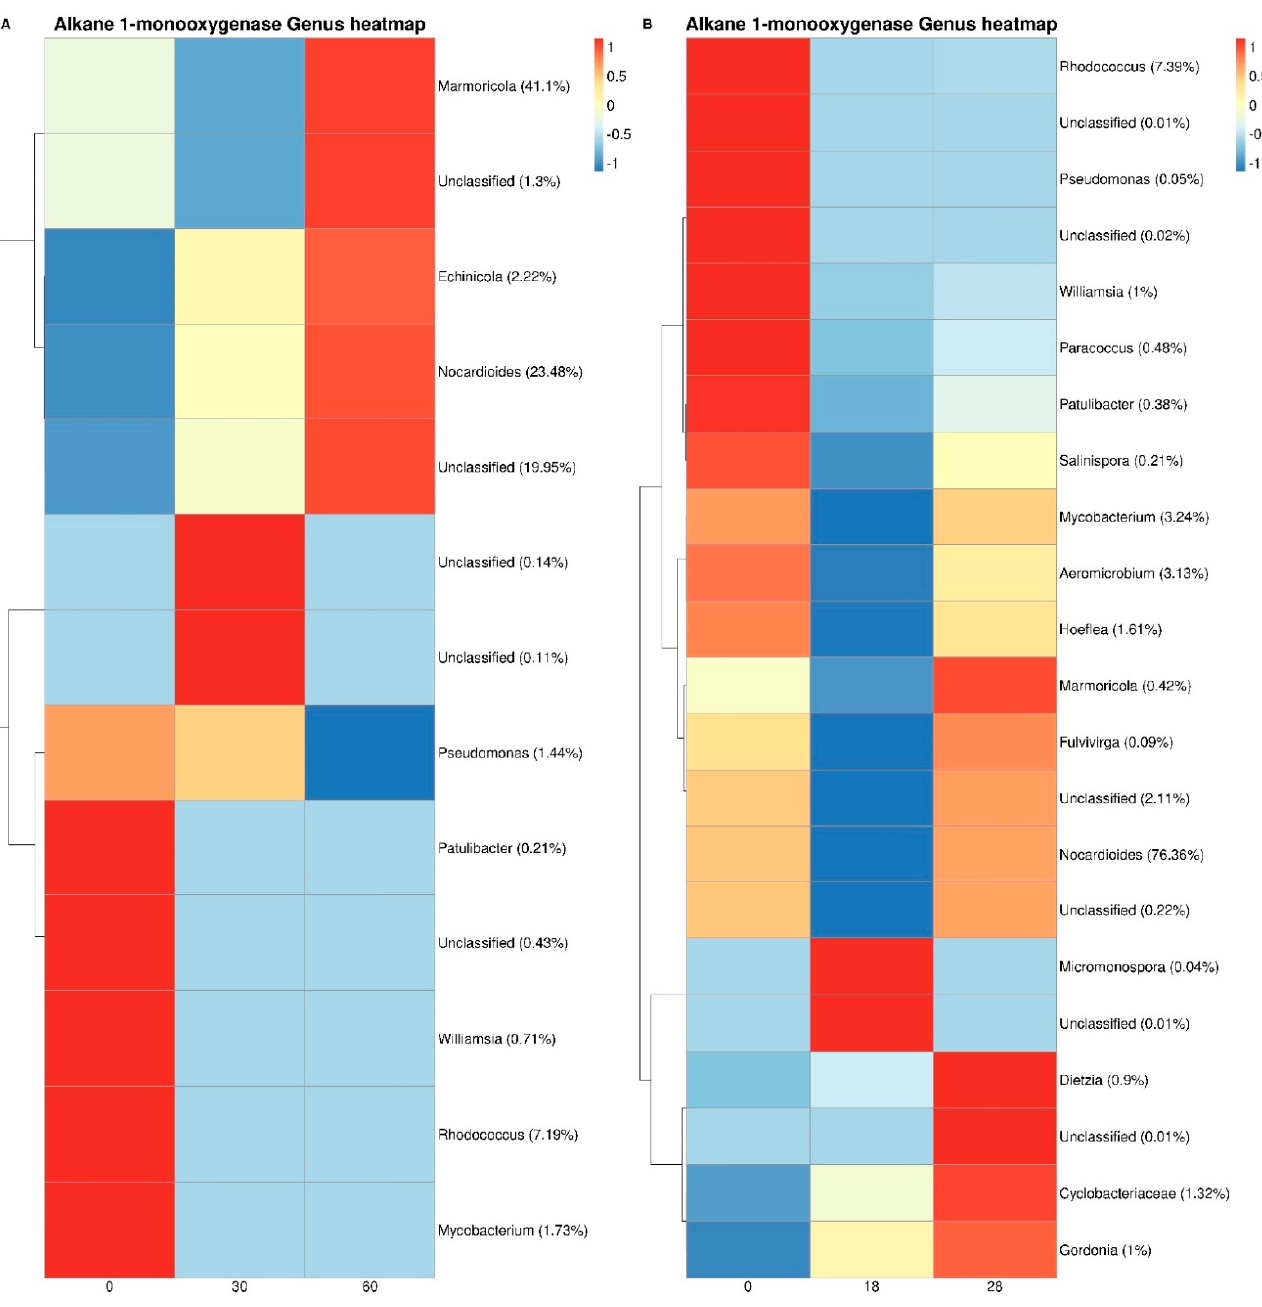
Figure 11. Functional heatmap for alkane 1-monooxygenase at genus level. Functional heatmap showing SMS community ( A ) and Lambertella sp. MUT 5852 community ( B ), genus contribution to alkane 1-monooxygenase (EC:1.14.15.3). Percentages reported near genus names represent the relative abundance of the sum of contribution of that genus per sample, against the total sum of contributions: a cut-off value of 0.005% was chosen. Hierarchical clustering was performed on rows by Pearson correlation, based on Euclidean distance. In order to evidence variation, a colour scheme that represents row-wise Z-scores of per genus contributions per sample was chosen. For this colour scheme, a Z value of 0 matches the reported percentage near the genus contributor.